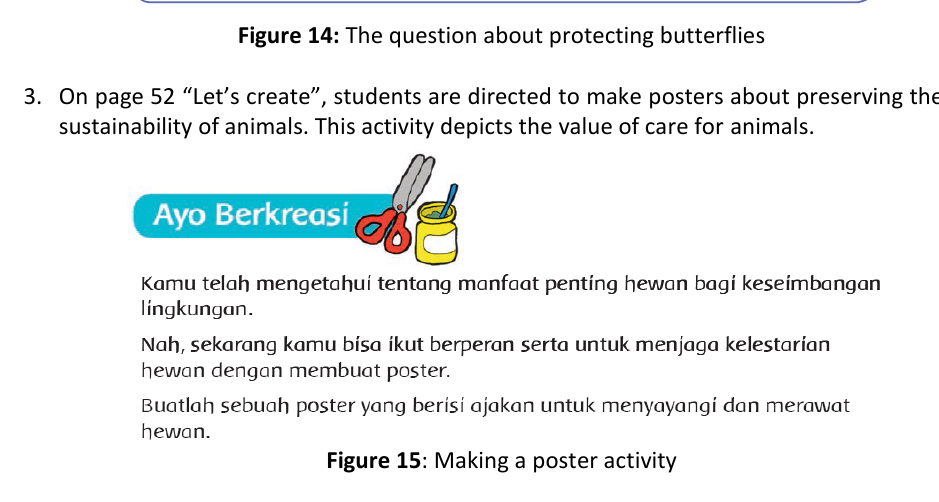
Figure 15 : Making a poster